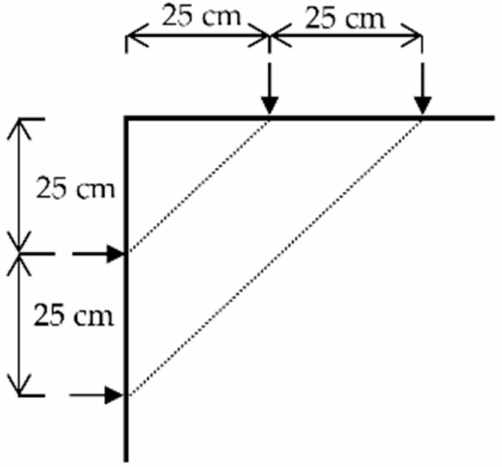
Figure 13. Scheme of transducer positioning in ultrasonic testing.